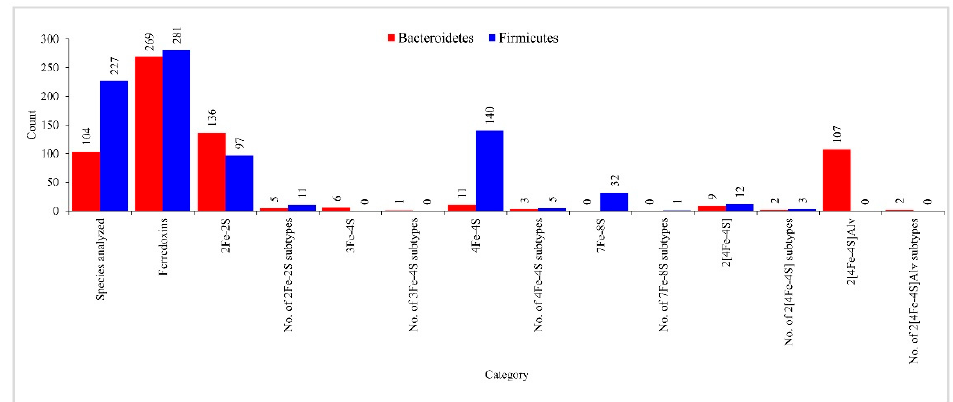
Figure 6. Comparative analysis of ferredoxins iron–sulfur (Fe-S) cluster features between Bacteroidetes - and Firmicutes -species. The number next to the bar indicates the count for that category.